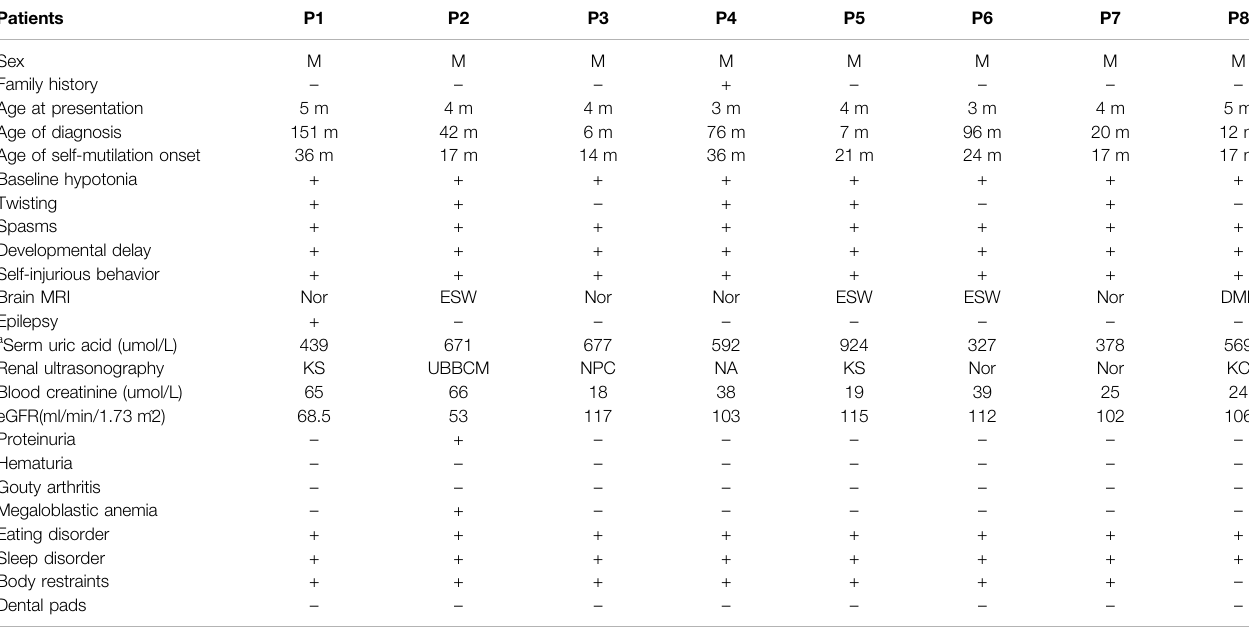
TABLE 1 | Clinical features of eight Chinese patients from eight unrelated families with LND when they are diagnosed. Patients